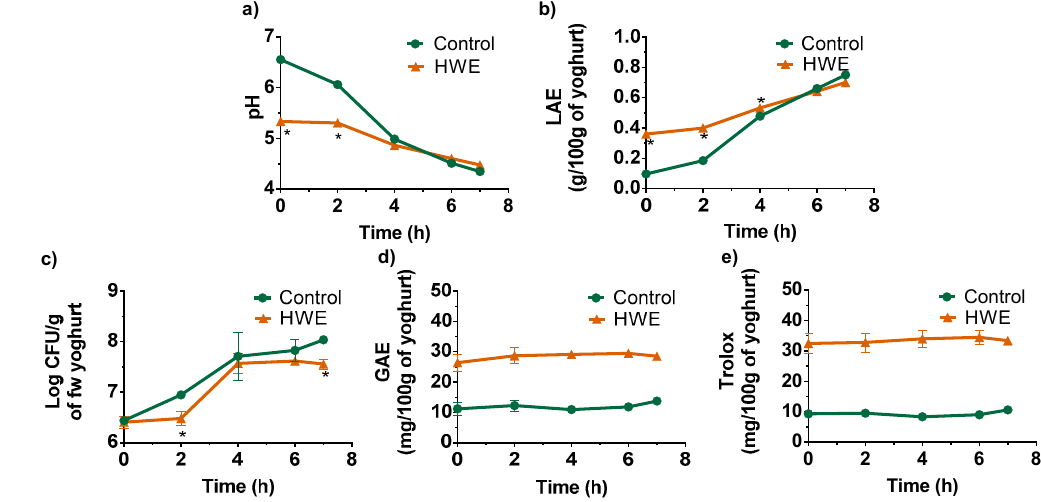
Figure 3. Evolution of ( a ) pH, ( b ) titratable acidity (expressed as lactic acid equivalents (LAE)/100 g of fresh weight yogurt)), ( c ) Streptococcus thermophilus counts (Log CFU/g of fresh weight yogurt),